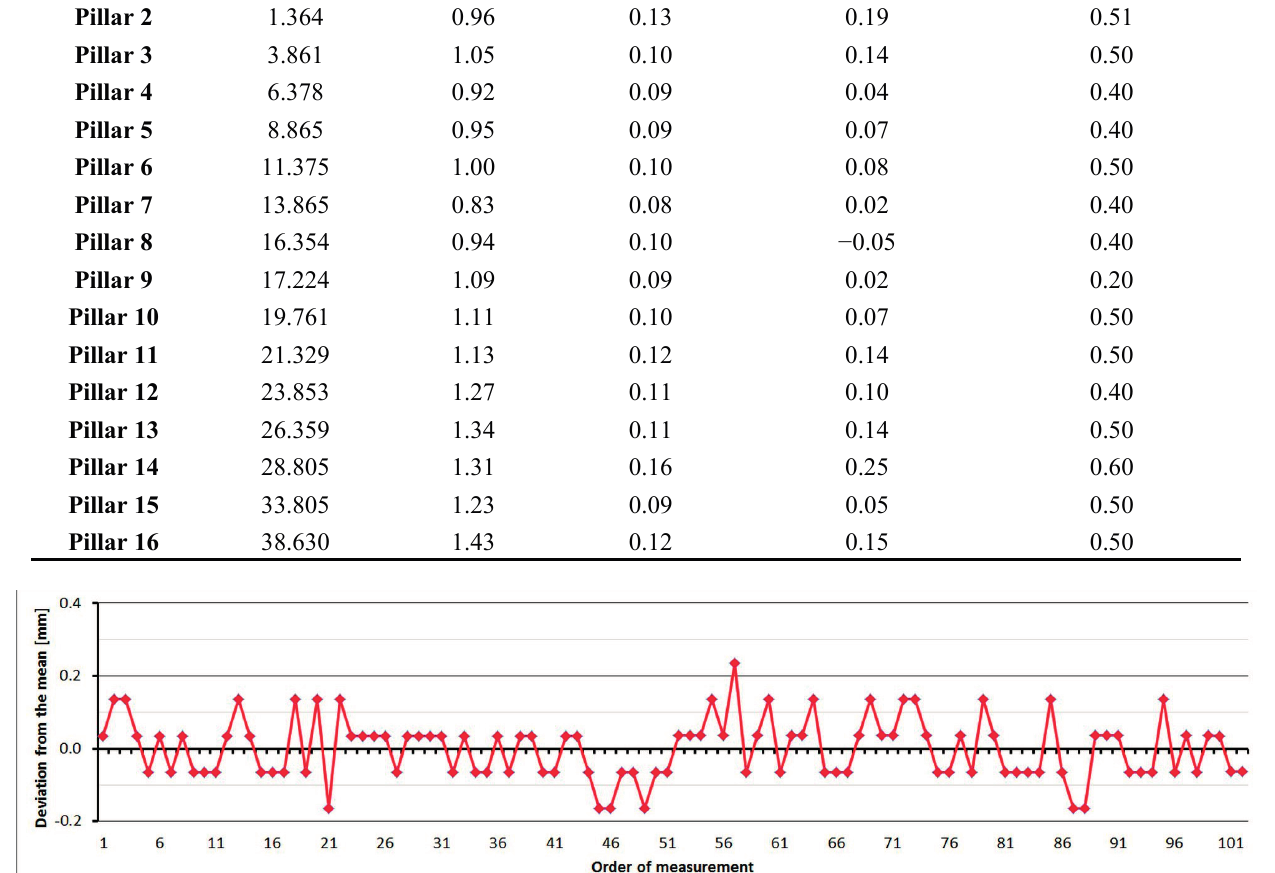
Figure 17. Leica TS06–Differences from average distance–pillar 7 (13.9